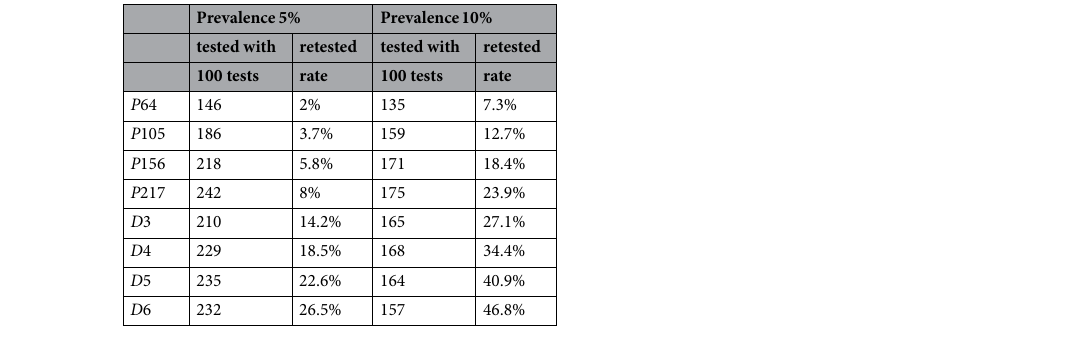
Table 2. Performance of the analyzed protocols, dilutions d = 3, . . . , 6